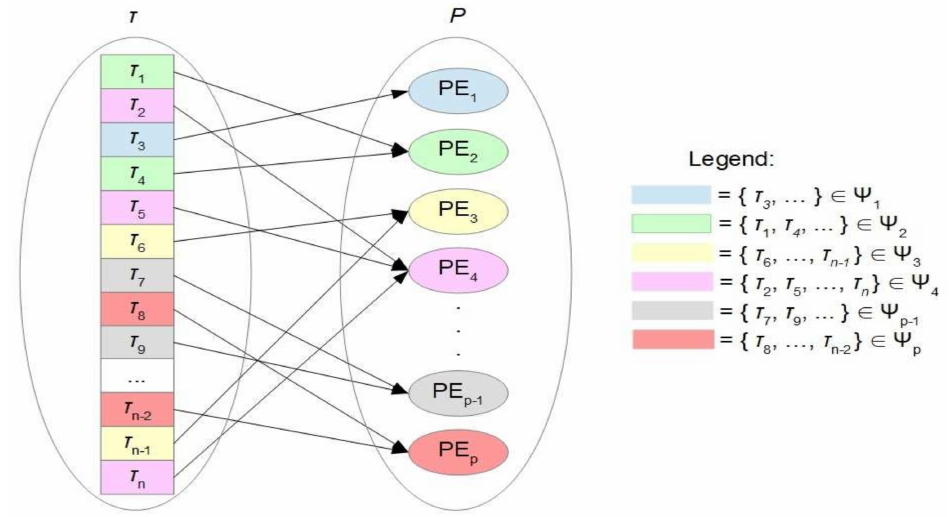
Figure 2. Assignment of Tasks to Processing